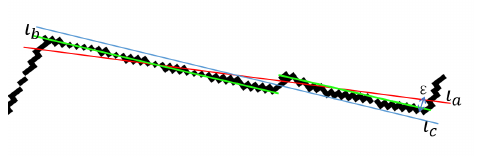
Figure 4. Rotational line fitting error introduced by corner edge pixels that fall within error threshold ε defined for the line ι a . The desired line is ι b or ι c . As shown with ι b and ι c , line direction is maintained.